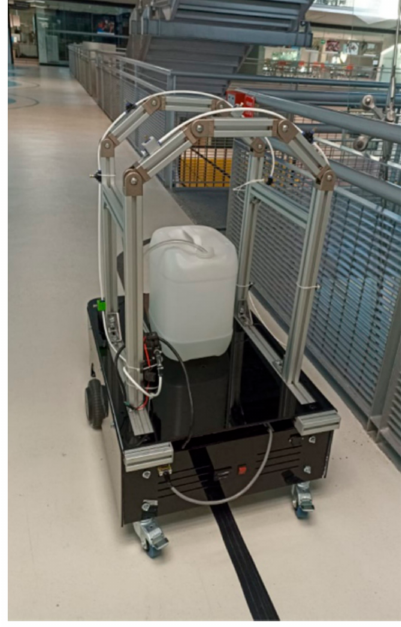
Figure 2. Following a line for repetitive